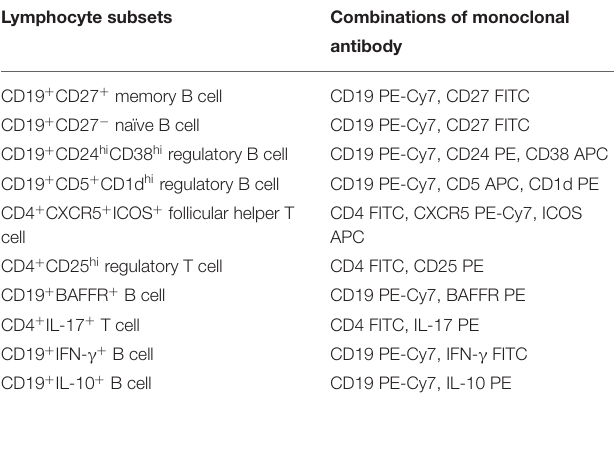
TABLE 1 | Detection of lymphocyte subsets by flow cytometry. Lymphocyte subsets Combinations of monoclonal